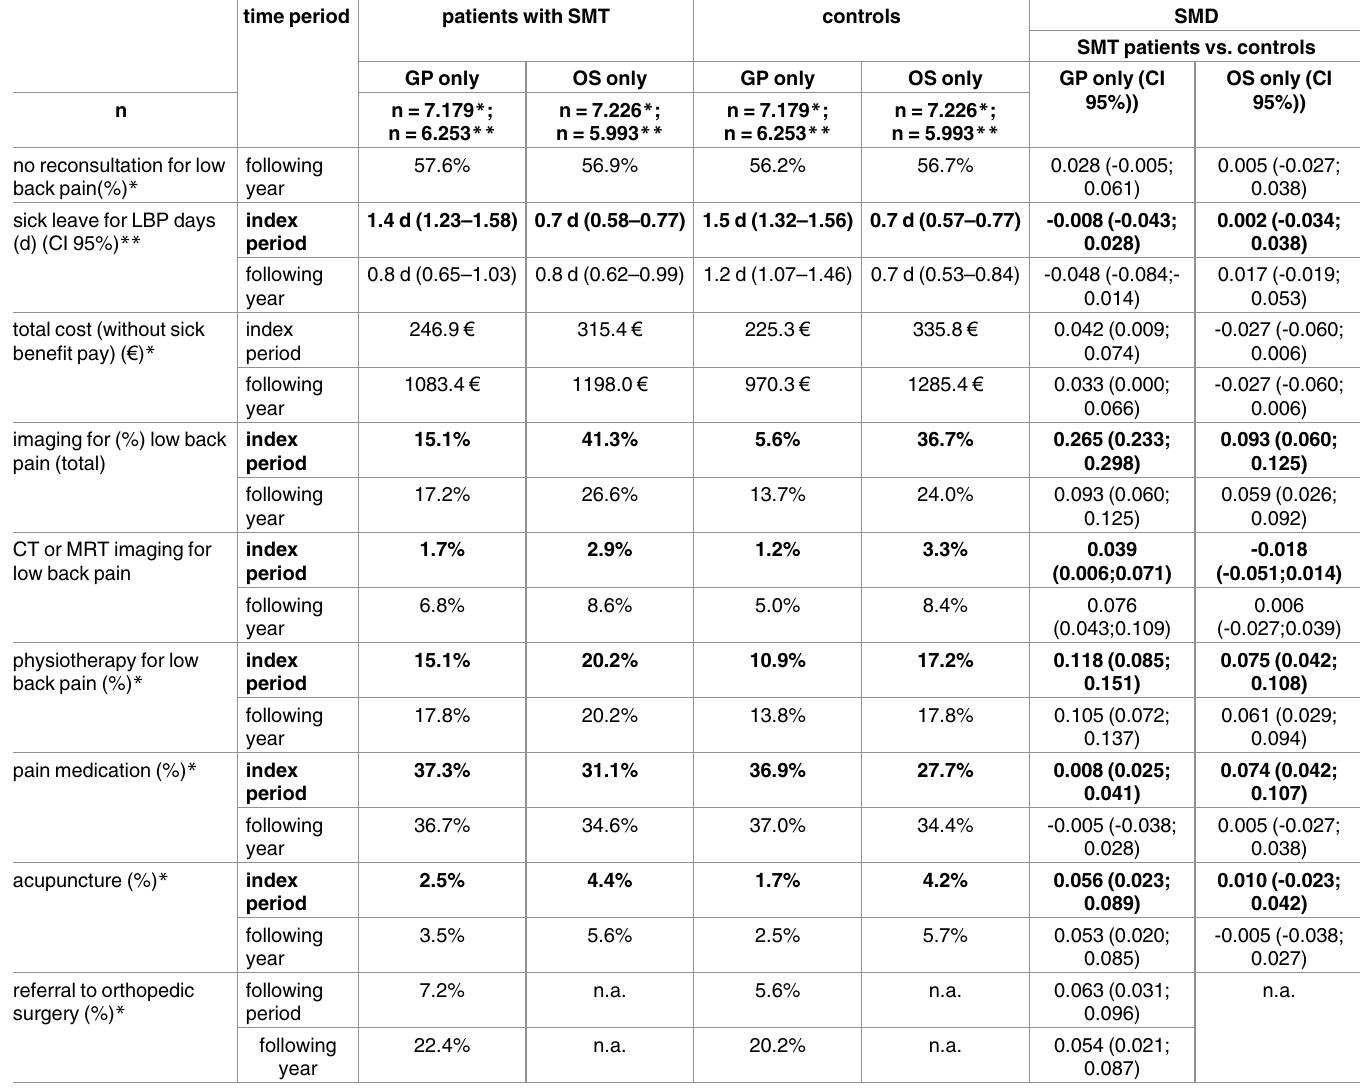
Table 3. Comparison between patients only seen by general practitioners (GP) or only orthopedic surgeons in the index period (OS). time period patients with SMT